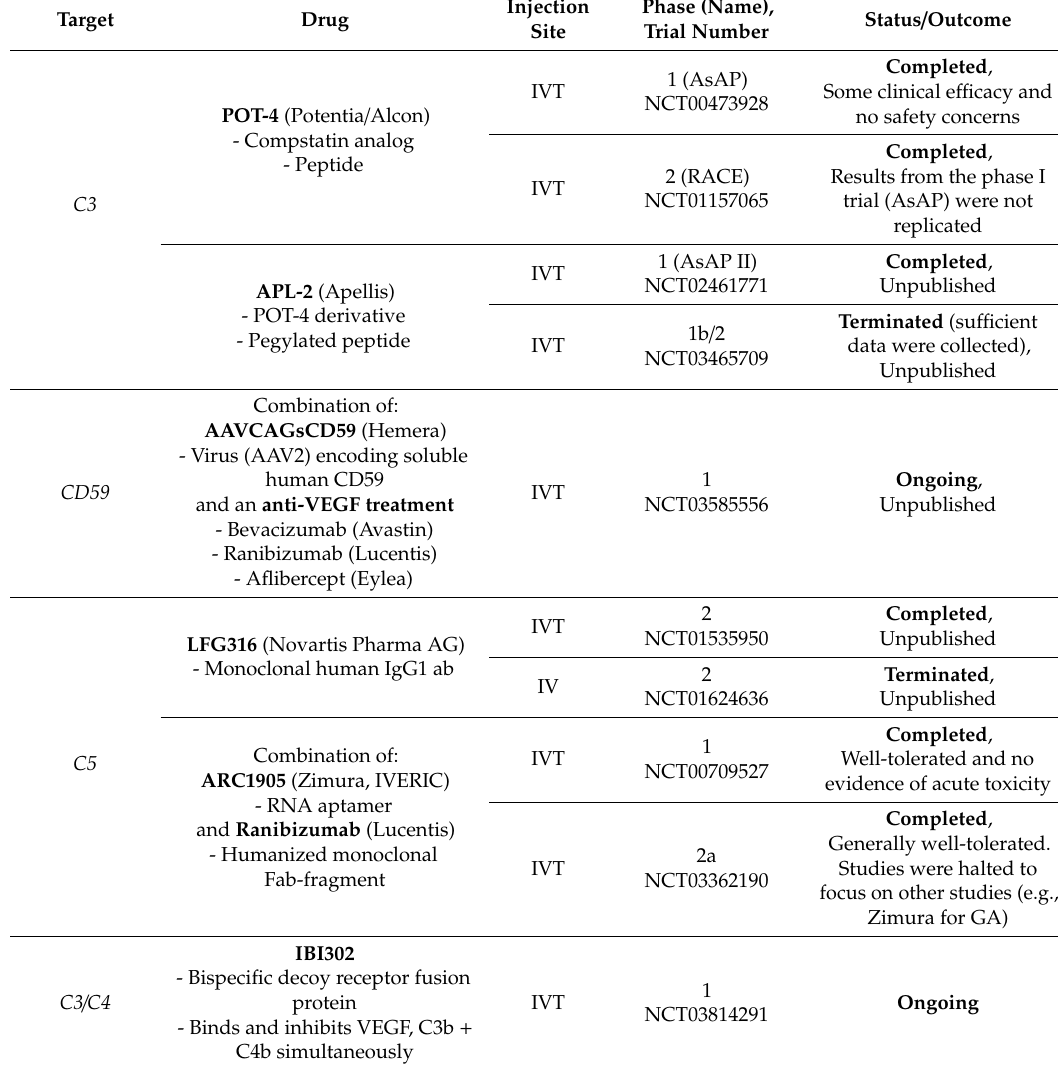
Table 1. Complement therapies in clinical trials for patients with wAMD